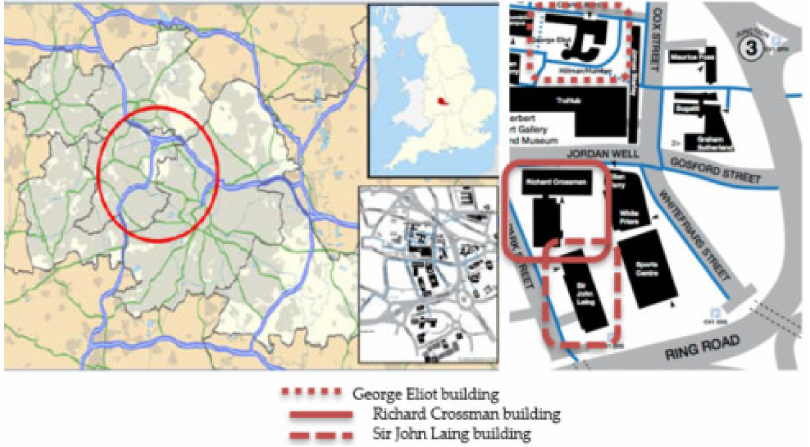
Figure 1. Location of Coventry and Coventry